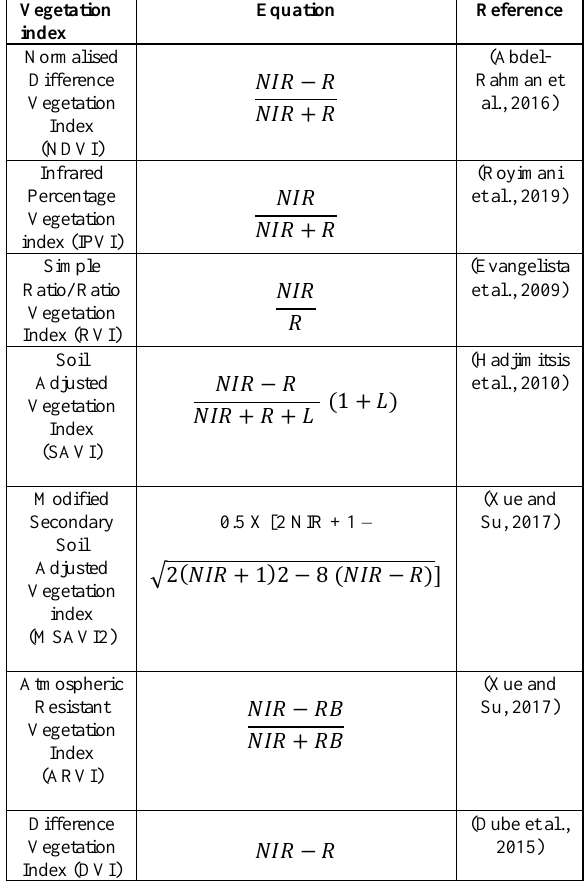
Table 2: Selected vegetation indices for the discrimination of Striga infested crop fields from other landcover classes: where RB in the Atmospheric Resistance Vegetation Index is the difference between the red band and blue